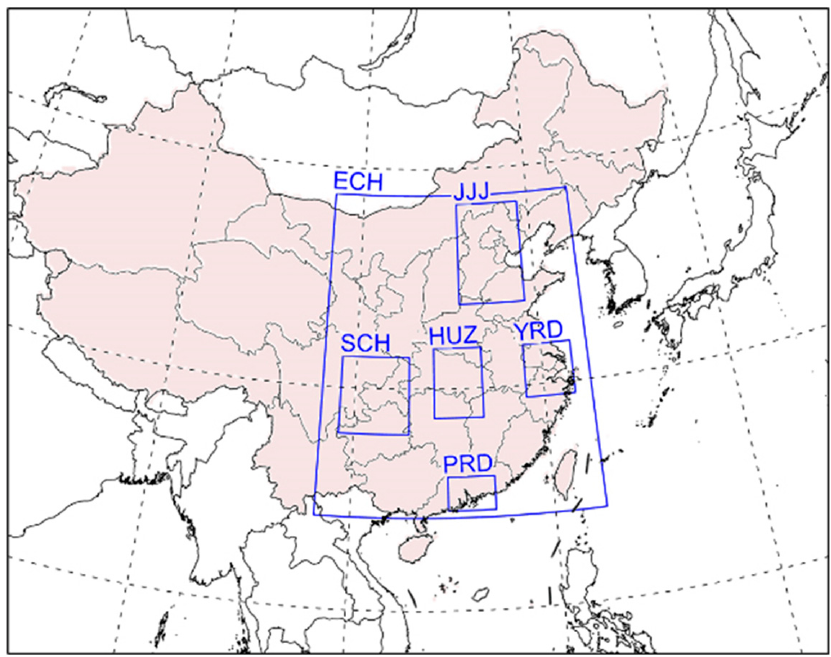
Figure 1. The modeling domain with a grid resolution of 27 km (182 × 232 cells) and the locations of the five typical regions (i.e., JJJ, YRD, PRD, SCH, and HUZ. J, Y, P, S, and H are marked in the center of the regions in the following figures), eastern China (ECH), and mainland China (CHA, shaded part). Based on the downscaled LUH2 data and the evolution of land-use types in 2050